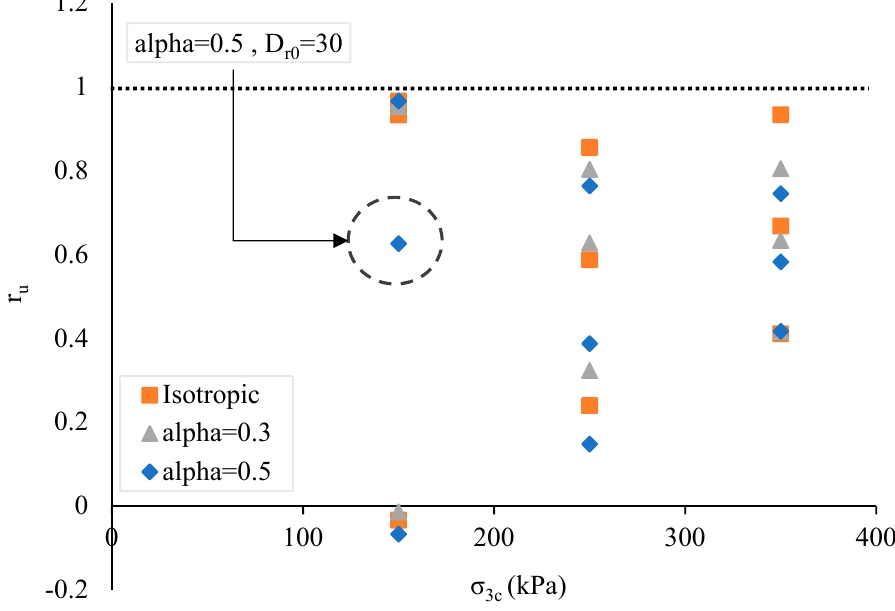
Figure 12. Pore water pressure ratio versus mean effective stress and effective confining pressure in isotropic and anisotropic stress condition. Alpha ( α ): the initial shear stress ratio.